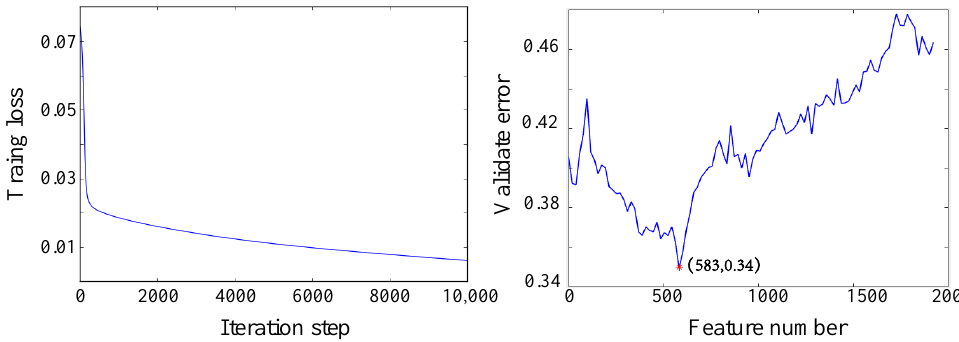
Figure 6. The training process of the CNN-based framework ( left panel ) and feature selection process of the SVM-based framework ( right panel ).